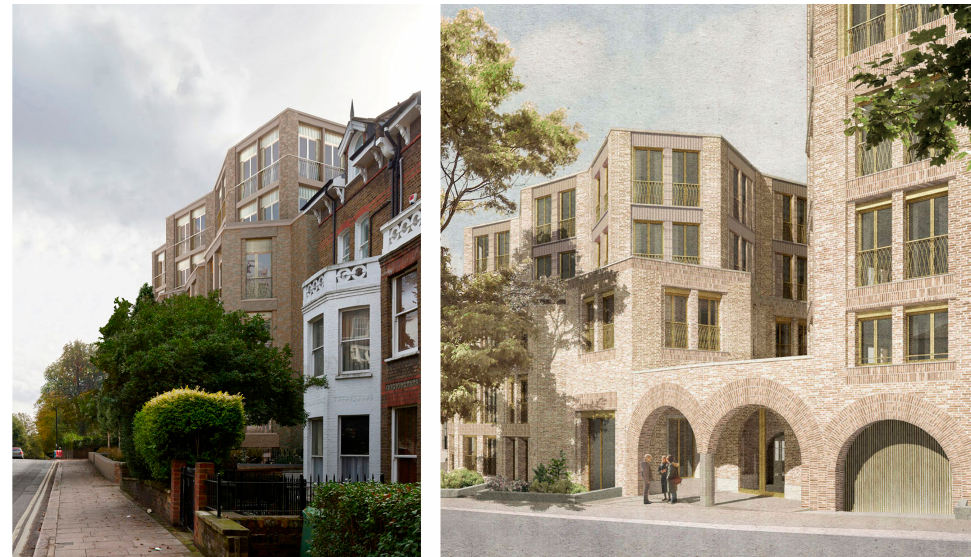
Figure 2. Mansion Block, Hampstead, Sergison Bates, 2017. © Sergison Bates.